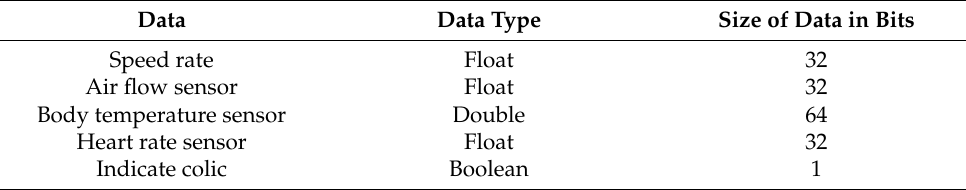
Table 4. Sensors Platforms and Sensors Data